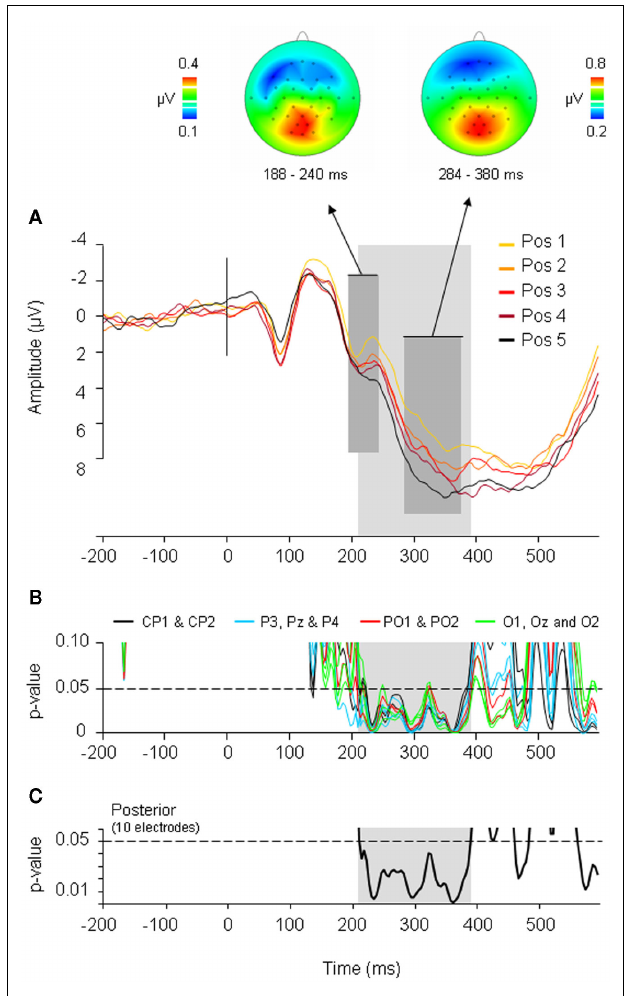
FIGURE 4 | Event-related potential (ERP) results and correlation analyses of the CSIE. (A) ERPs elicited by the five ordinal positions within the semantic categories.The waveforms depicted are the linear derivation of the 10 posterior electrodes where significant effects were present (CP1, CP2, P3, Pz, P4, PO1, PO2, O1, Oz, O2).The dark gray area refers to the P2 peak and P3 peak showing a linear and cumulative increase in amplitude with each ordinal position. Above the topographic maps of the averaged differences waves of the five ordinal positions for the P2 and P3 are shown. The light gray area refers to the time frame (208–388ms) where ERP amplitudes correlated with ordinal position and RTs. (B) Significance graph of the correlation analyses at each sampling rate (4ms) between RTs and ERP amplitudes at the 5 ordinal positions for the 10 posterior electrodes. (C) Significance graph of the correlation analyses at each sampling rate (4ms) between RTs and ERP amplitudes at the 5 ordinal positions averaged over the 10 posterior electrodes. Correlations were reliably below the 0.05 significance level (following a row of 12 consecutive significant t -test; cf. Guthrie and Buchwald, 1991) between 208 and 388ms after picture presentation (light gray area). (Figure taken from Costa et al.,